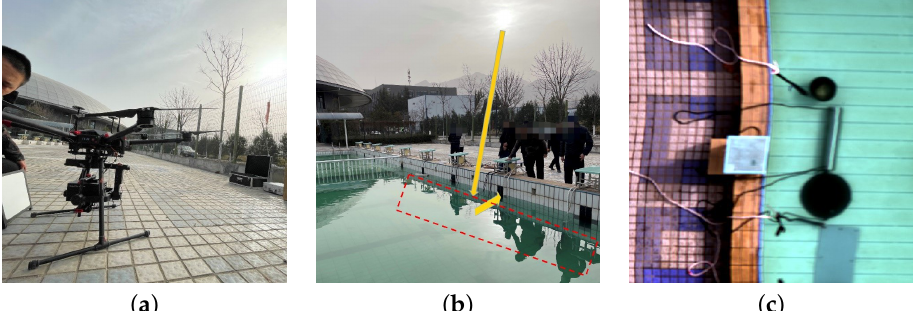
Figure 3. Photos of the experiment site. ( a ) Capture ‘white board’. ( b ) Water surface polarization and reflection. ( c ) The UAV-captured image with slight spatial